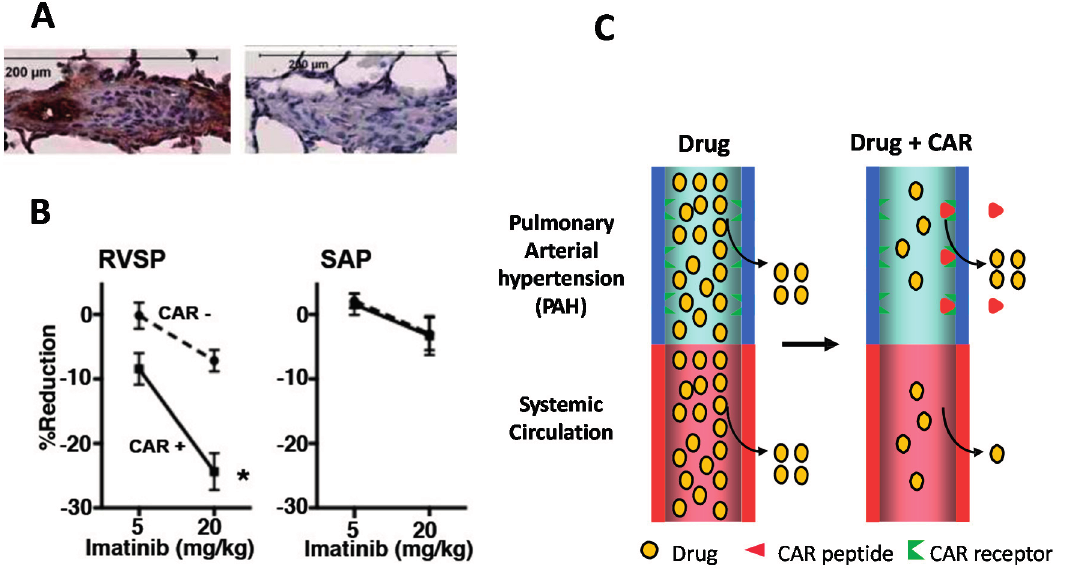
Figure 4. CAR peptide homes to inflammatory vasculature in pulmonary arterial hypertension (PAH) and induced target-tissue selective vasodilation in PAH. ( A ) PAH was induced in rats by a single subcutaneous injection of SU5416 and three week exposure to hypoxia (10% O 2 ) followed by six weeks of normoxia [42,47]. CAR peptide accumulates in remodeled pulmonary arteries (A/C: occlusive neointimal formation) [42,47]. Little signal was detected in lung lesions of the PAH rats administered with CAR mutant peptide; ( B ) CAR peptide was given orally (p.o.) at the same time with Imatinib (Gleevec). CAR peptide makes drugs tissue-selective in PAH, i.e. , the drugs are substantially more potent in the pulmonary vasculature (RVSP) where the PAH takes place, whereas the blood pressure lowering effect induced by CAR co-administration is unchanged on the systemic side of the circulation (SAP), * p < 0.05; and ( C ) Schematic presentation of targeted delivery by the bystander effect induced by vascular homing peptide